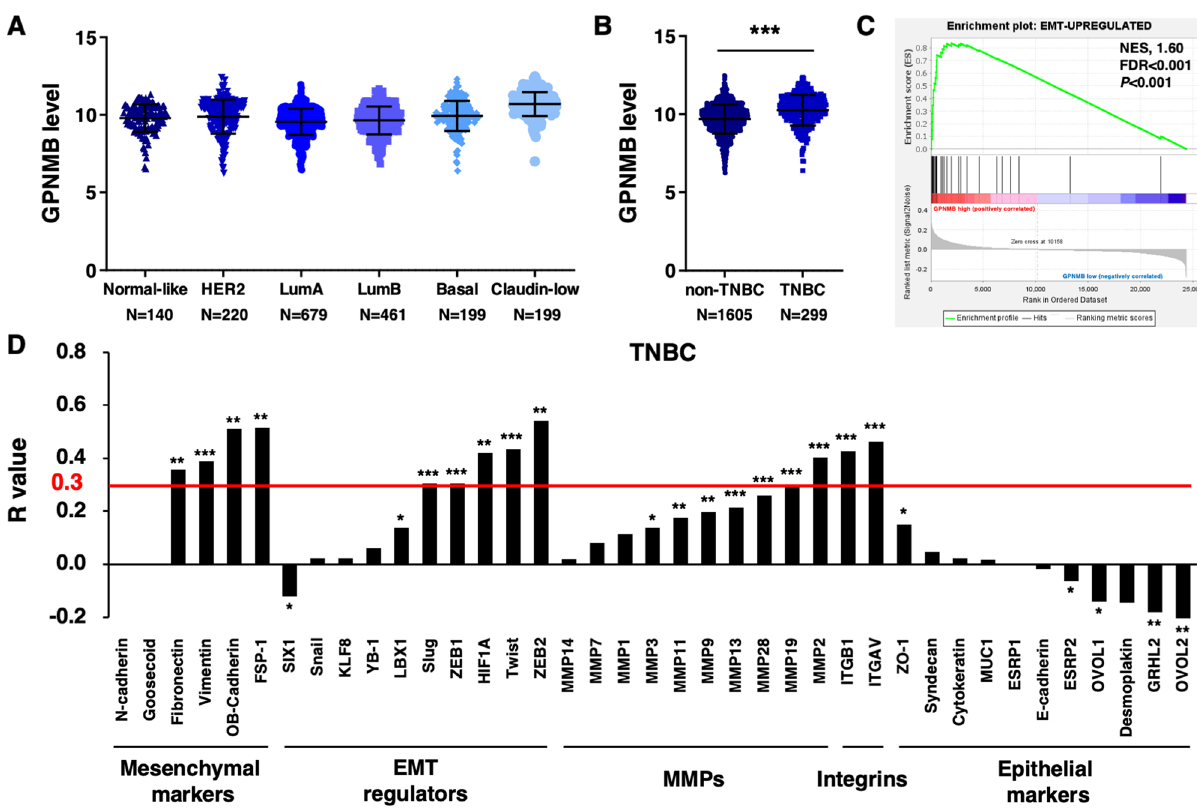
Figure 3. GPNMB is overexpressed in TNBC patients and correlated with EMT-associated genes. ( A – D ) GPNMB transcript data from Molecular Taxonomy of Breast Cancer International Consortium (METABRIC) in cBioPortal was analyzed. ( A ) Expression of GPNMB transcript was compared based on PAM50 classification. ( B ) TNBC harbored higher GPNMB level compared to non-TNBC based on gene expression classification. *** P < 0.001. ( C ) Gene set enrichment analysis (GSEA) of METABRIC data showed enrichment of an EMT- upregulated signature in GPNMB high patients. ( D ) The correlations of GPNMB with mesenchymal markers, EMT regulators, MMPs genes, integrins and epithelial markers were analyzed. The Pearson correlation coefficient above 0.3 was considered as positive